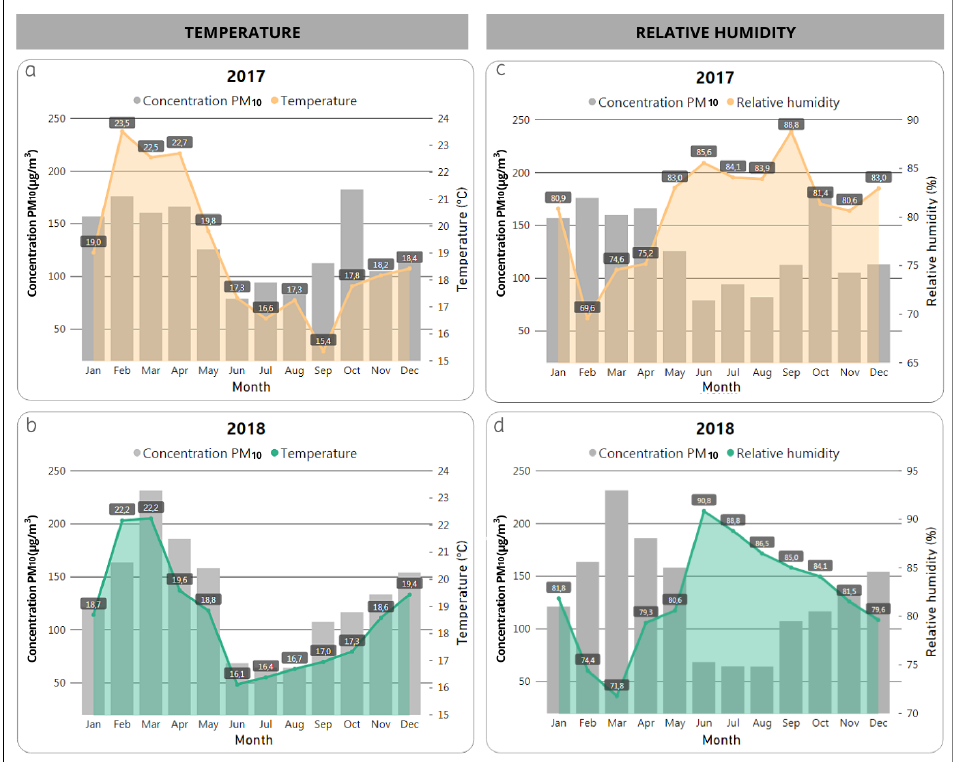
Figure 8. Monthly distribution of PM 10 concentration and temperature in year ( a ) 2017 and ( b ) 2018 at the HCH station. Monthly distribution of PM 10 concentration and relative humidity in year ( c ) 2017 and ( d ) 2018 at the HCH